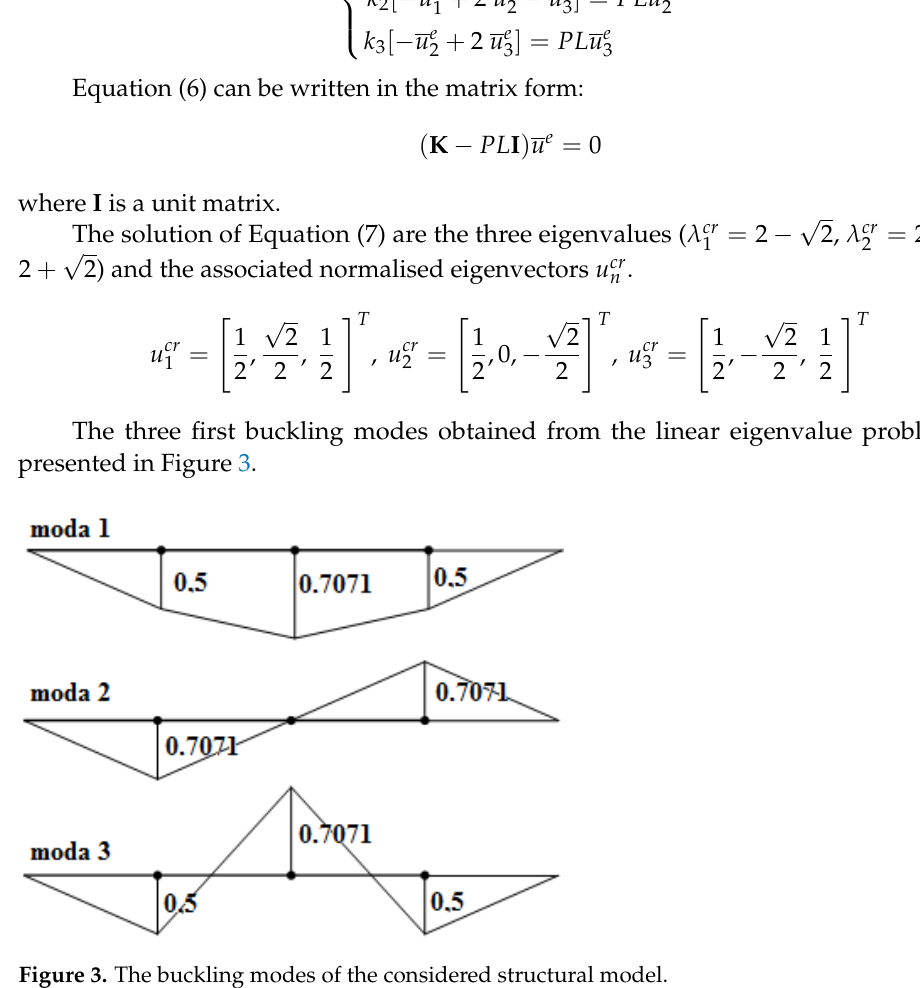
Figure 3. The buckling modes of the considered structural model.